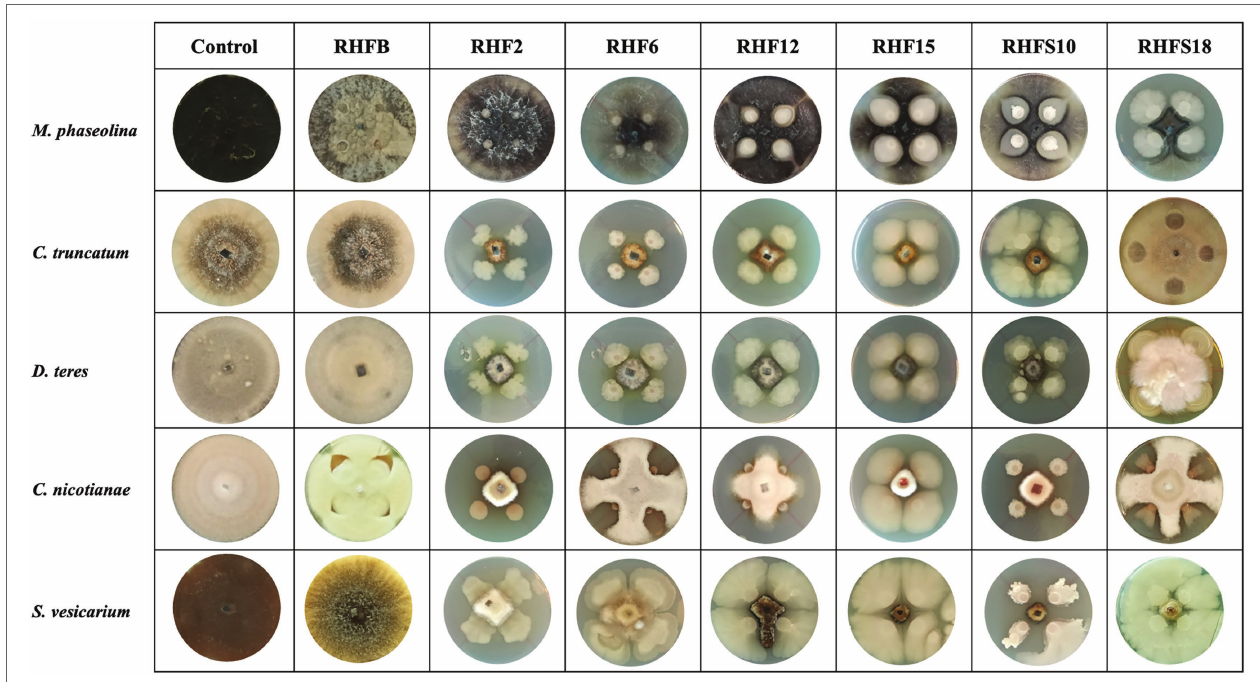
FIGURE 4 | Representative photographs of dual culture assay for in vitro mycelial growth inhibition of fungal